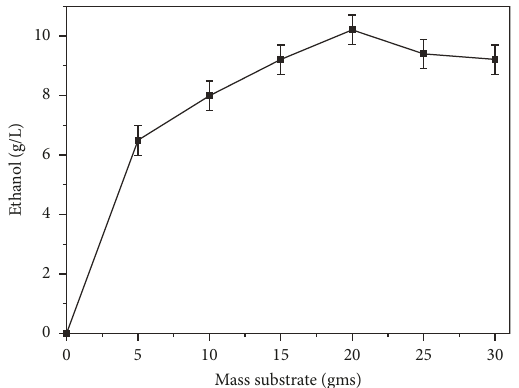
Figure 5: The relation of mass substrate for ethanol